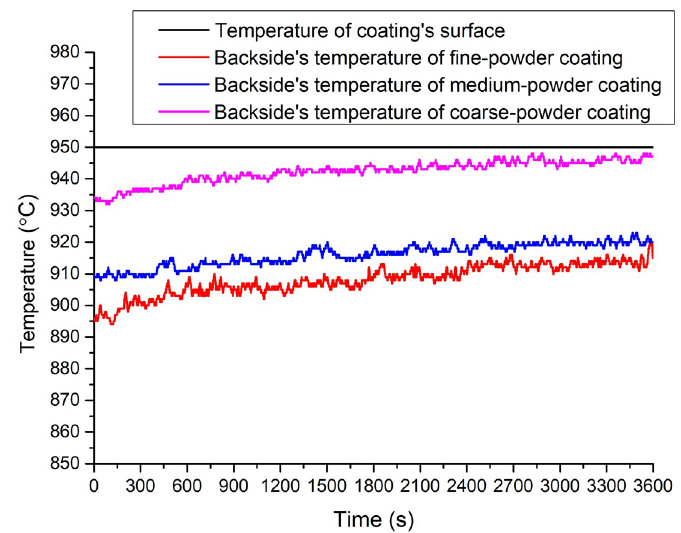
Figure 7. Comparison of thermal insulation of as-sprayed alumina coatings produced by fine, medium, and coarse particle size for a hold time of 60 min.